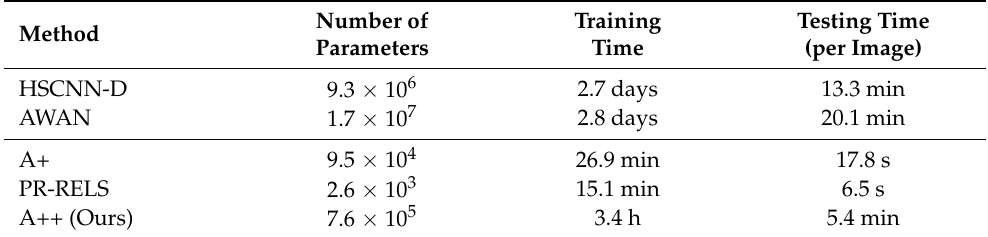
Table 2. The reference number of model parameters, training time and testing (reconstruction) time. Number of Method